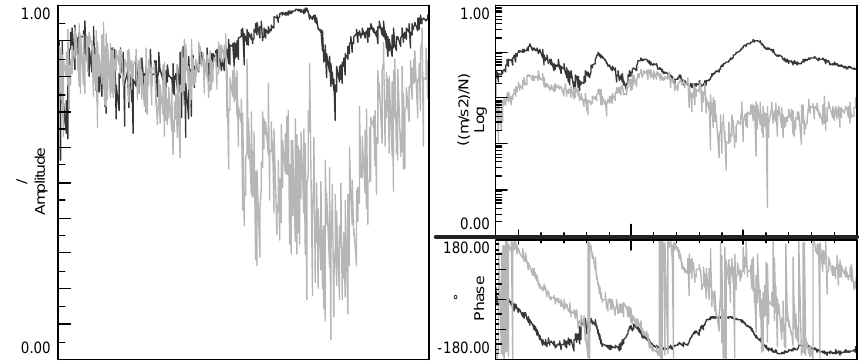
Fig. 5. Flight flutter test data. (Left) multiple coherences of a sensor at the wing tip close to the excitation (black) and a sensor at the back of the plane (grey); (Right) corresponding FRFs. The frequency axis is blind for confidentiality